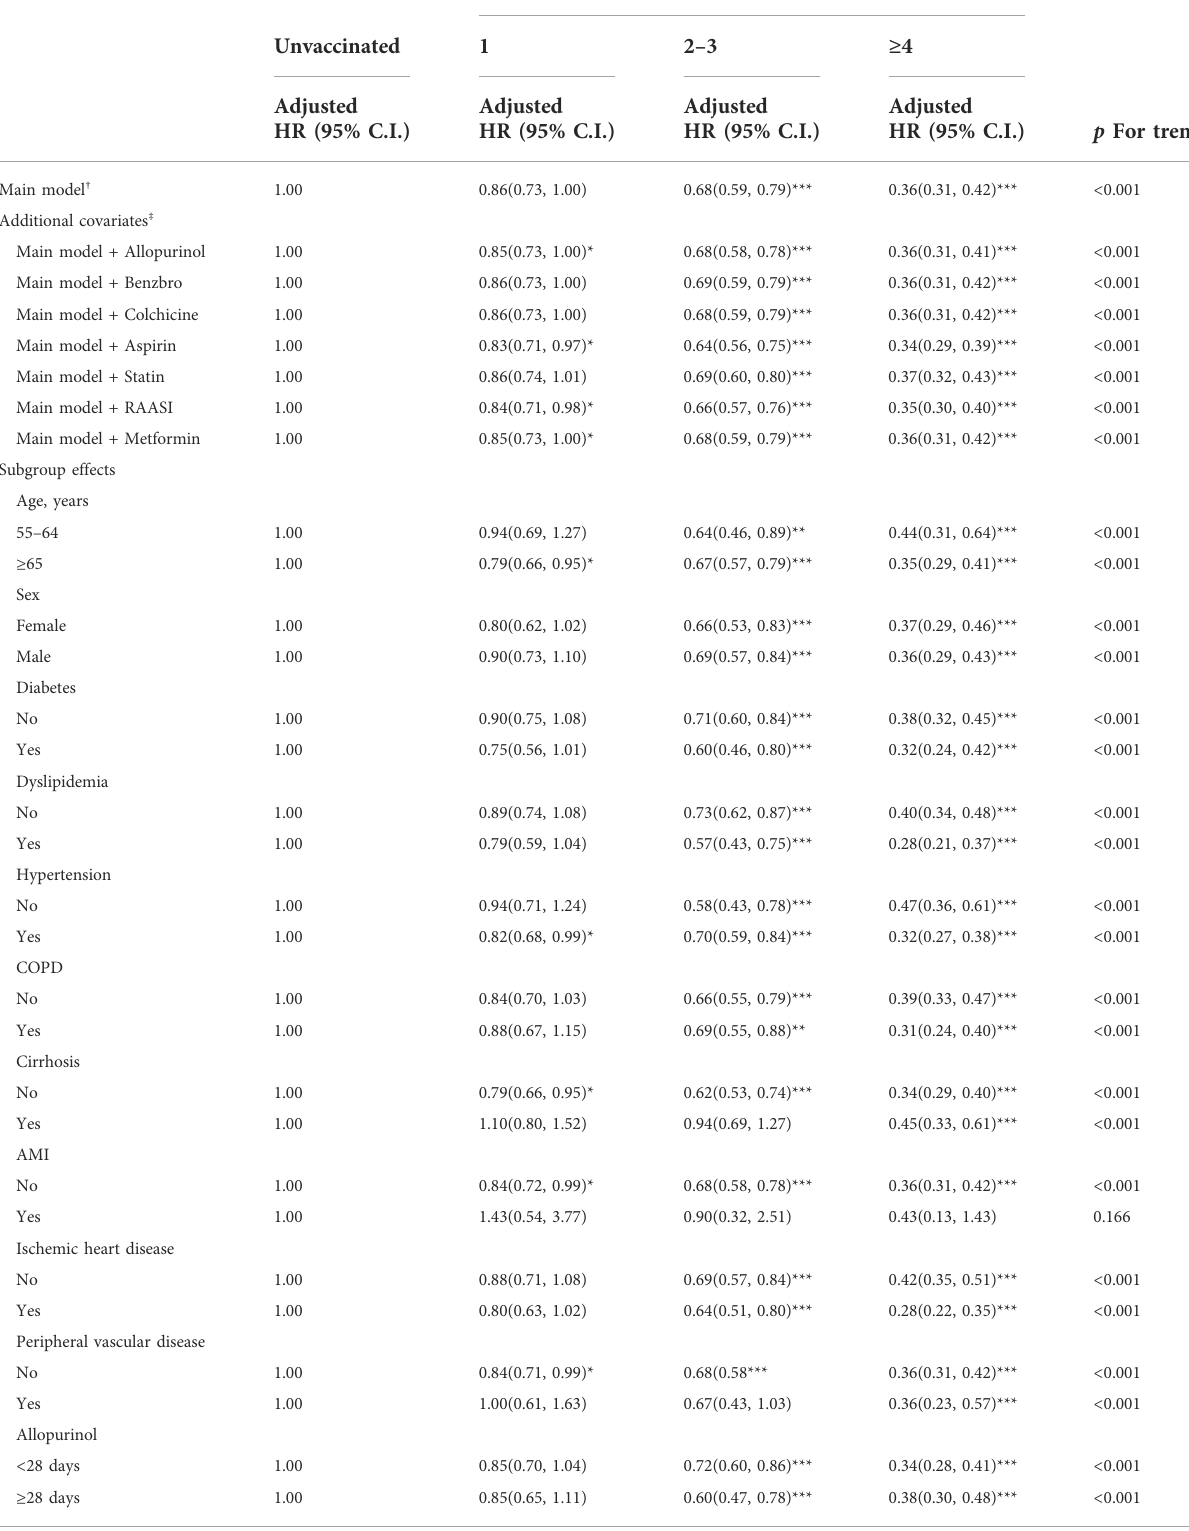
TABLE 5 Sensitivity analysis of adjusted HRs of vaccination in risk reduction of atrial fi brillation in all Sseasons.